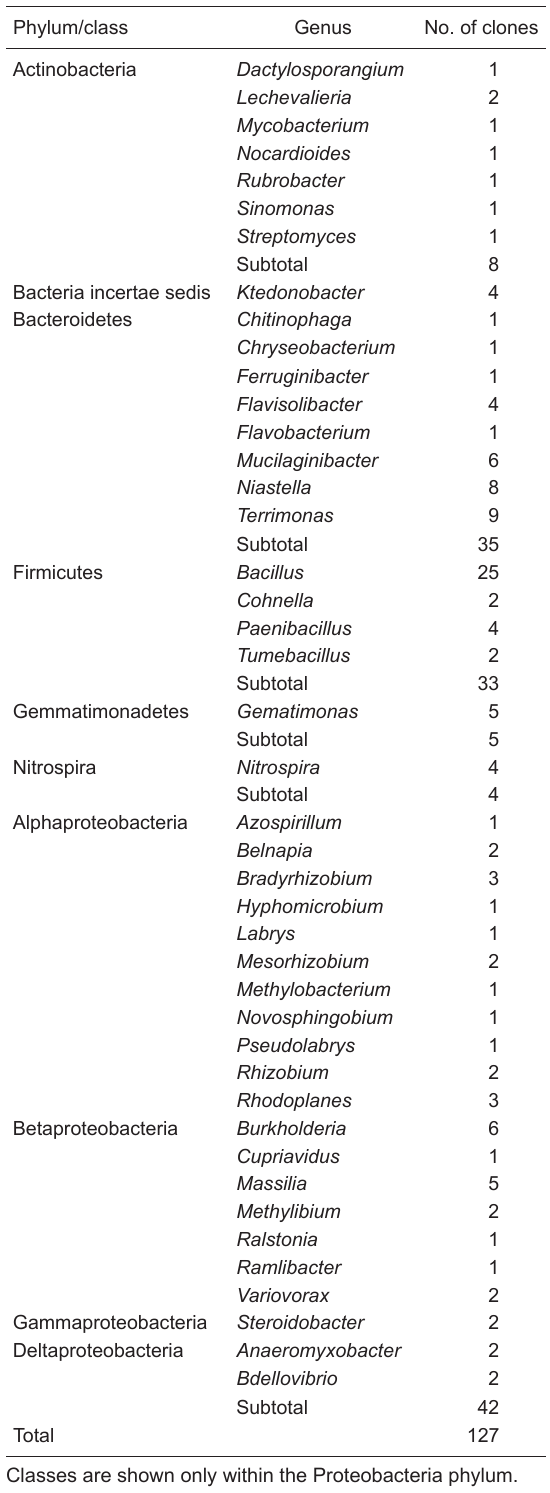
Table 3. Genus assignment for clones from sugarcane rhizo- sphere on the basis of 16S rRNA gene sequences.